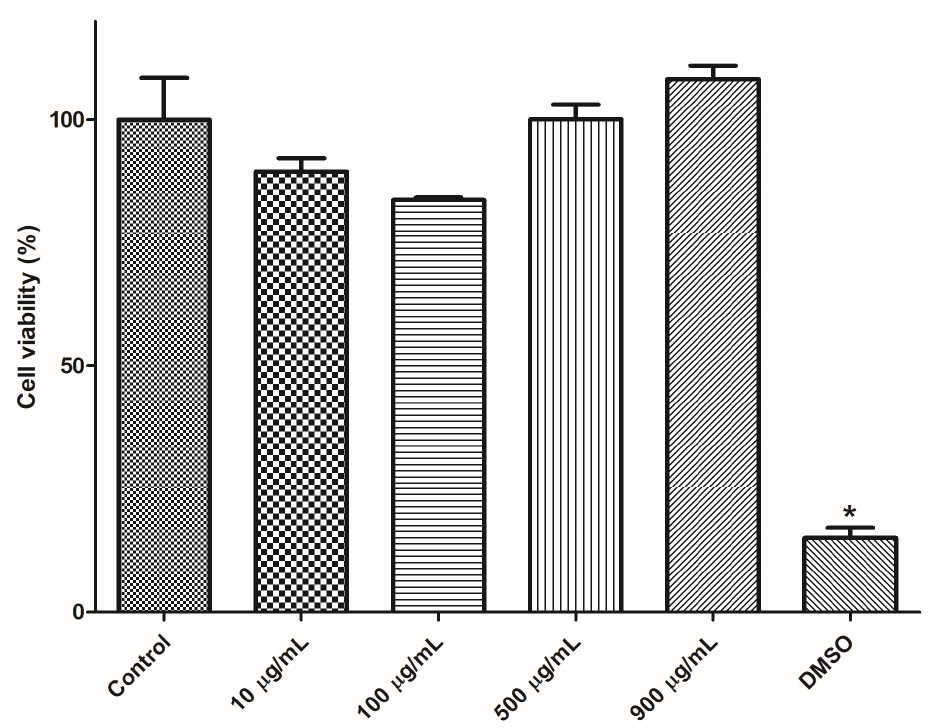
Figure 9. Cytotoxicity assessment for polyacrylic acid/ Schizochytrium sp. (PAA/Schizo) microgels in mice splenocytes. Cells from BALB/c mice were exposed during 24 h to PAA/Schizo microgels at different concentrations and viability was subsequently measured by the resazurin assay. Vehicle (PBS) and 5% dimethyl sulfoxide (DMSO) were used as controls. Data represent mean ± standard error of the mean (SEM) (n = 3). Statistic differences (* p < 0.05) are indicated by the asterisk.